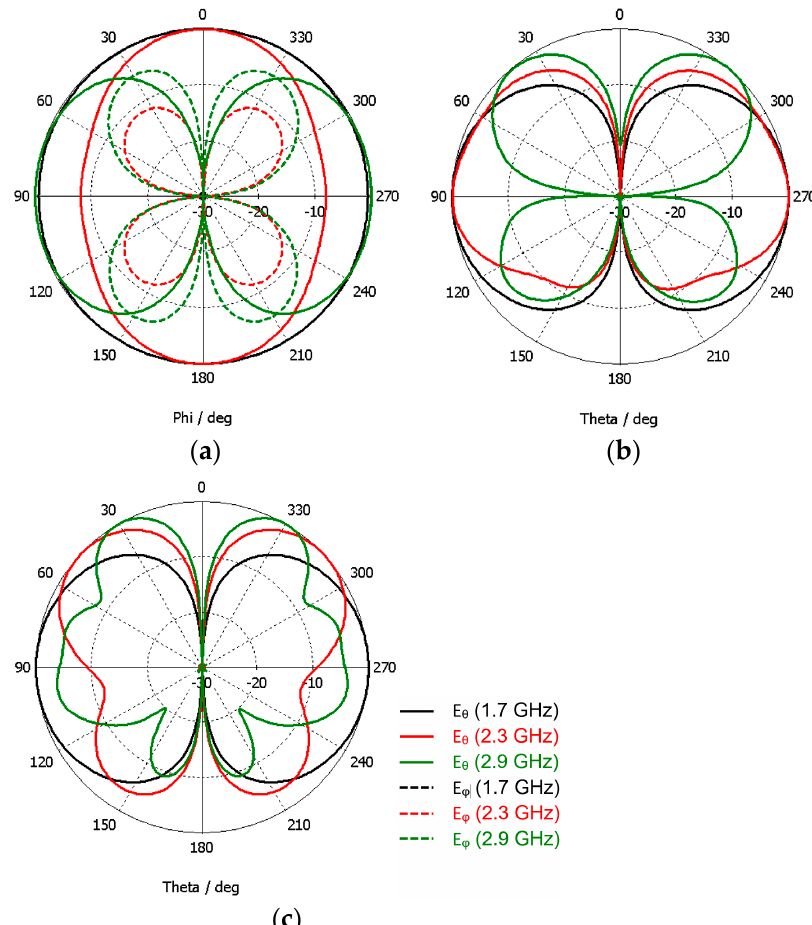
Figure 9. CST simulated normalized current distribution on the modified octagonal monopole configuration. ( a ) 0.7 GHz; ( b ) 2.1 GHz; ( c ) 3.5 GHz. The simulated far-field 2D radiation pattern results are shown in Figure 10.